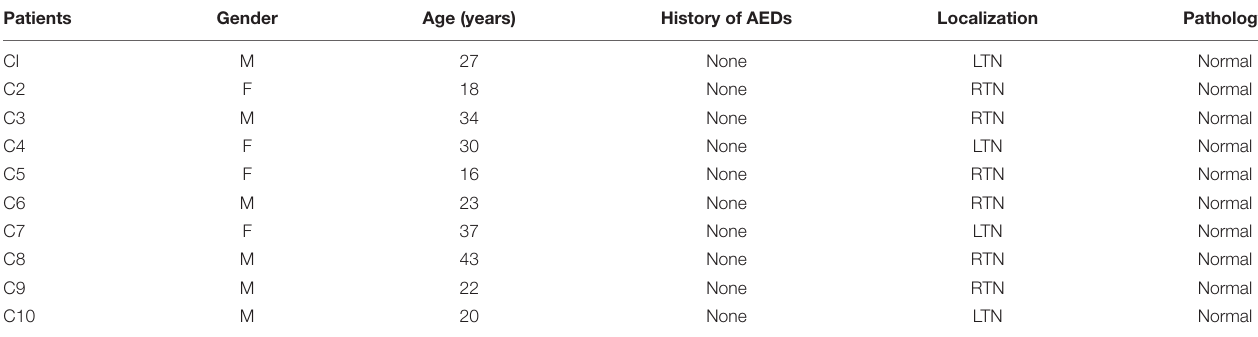
TABLE 2 | Clinical features of the non-epileptic controls. Patients Gender Age (years) History of AEDs